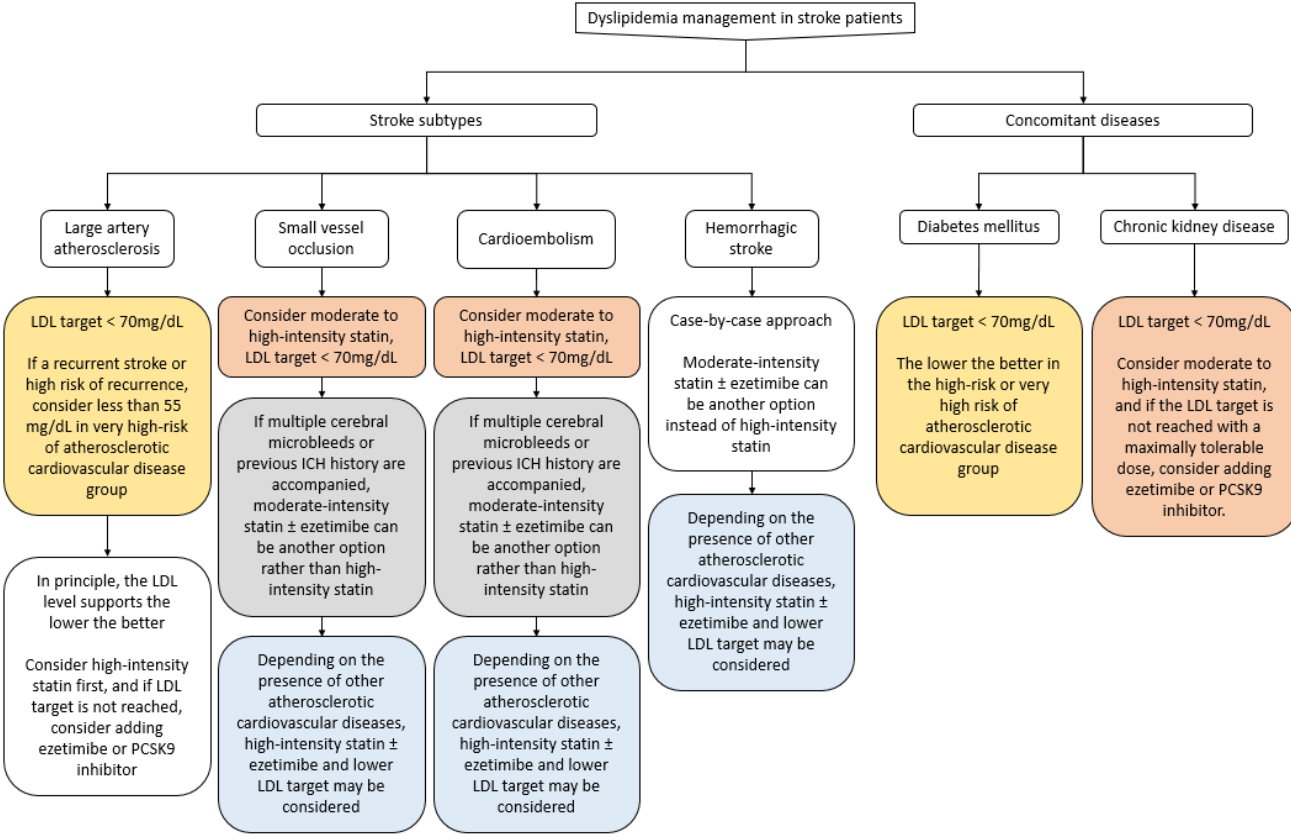
Figure 5. Management of dyslipidemia for secondary stroke prevention.